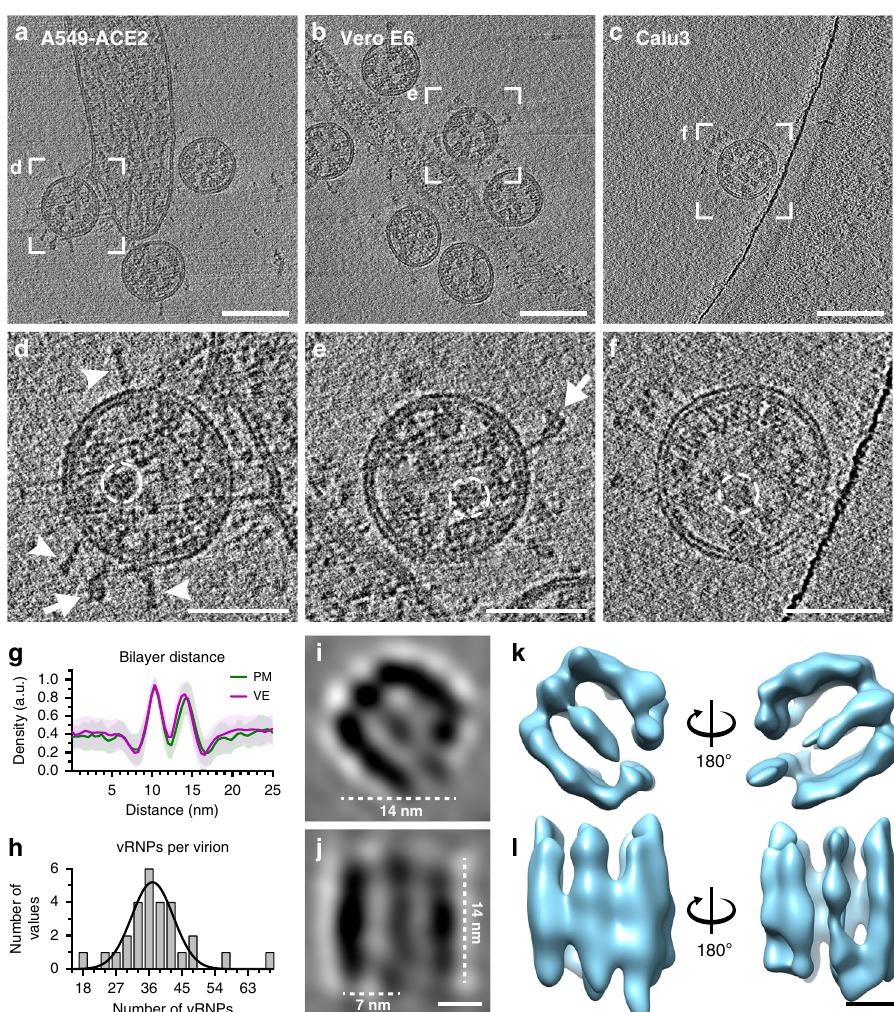
Fig. 5 Structural analysis of extracellular virions. a – c Slices of tomograms showing extracellular virions released from A549-ACE2, VeroE6, and Calu3 cells, respectively. d – f magni fi ed views of (a – c), for better visualization, 10 slices were averaged. Exemplarily, S glycoproteins in a pre-fusion (arrow) or post-fusion conformation (arrowhead) are marked, vRNP complexes are encircled with dashed lines. g Plot pro fi le through the viral envelope (VE, magenta) of virions released from VeroE6 cells and adjacent plasma membrane (PM, green) to determine monolayer separation ( n = 129 and 49, respectively, SD indicated). h Number of vRNP complexes per virion ( n = 28) released from VeroE6 cells. Data are represented as a histogram with a bin size of 3 and Gaussian fi t ( R 2 = 0.8645). i , j Subtomogram average of vRNP complexes from 1570 individual vRNPs found in 15 tomograms. Central XZ- slice ( i ) and XY-slice ( j ) are shown. k , l Isosurface representation of the subtomogram average (Movie S5) shown from the top ( k ) and side view ( l ). Scale bars: a – c 100 nm; d – f 50 nm; i – l 5